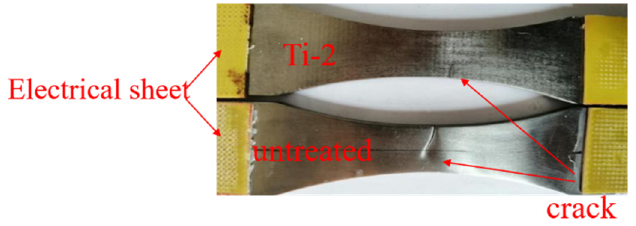
Figure 3. Appearance of fatigue fracture samples for untreated TC6 titanium alloy and LSP-treated Figure Ti-2.